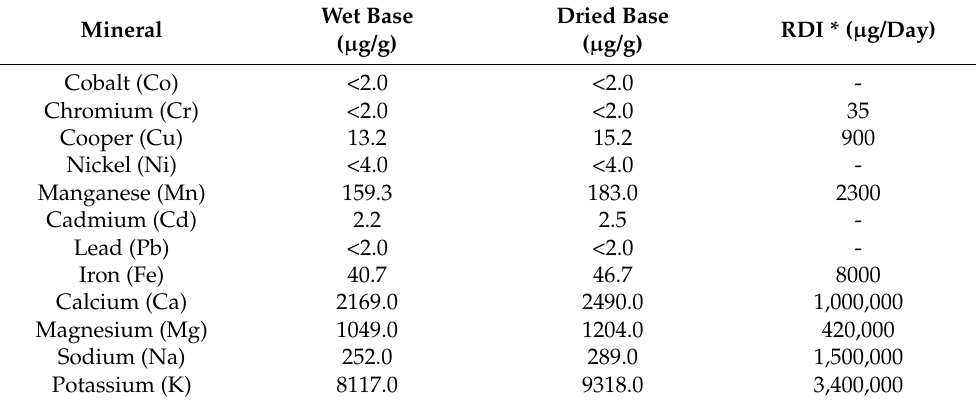
Table 3. Mineral composition of